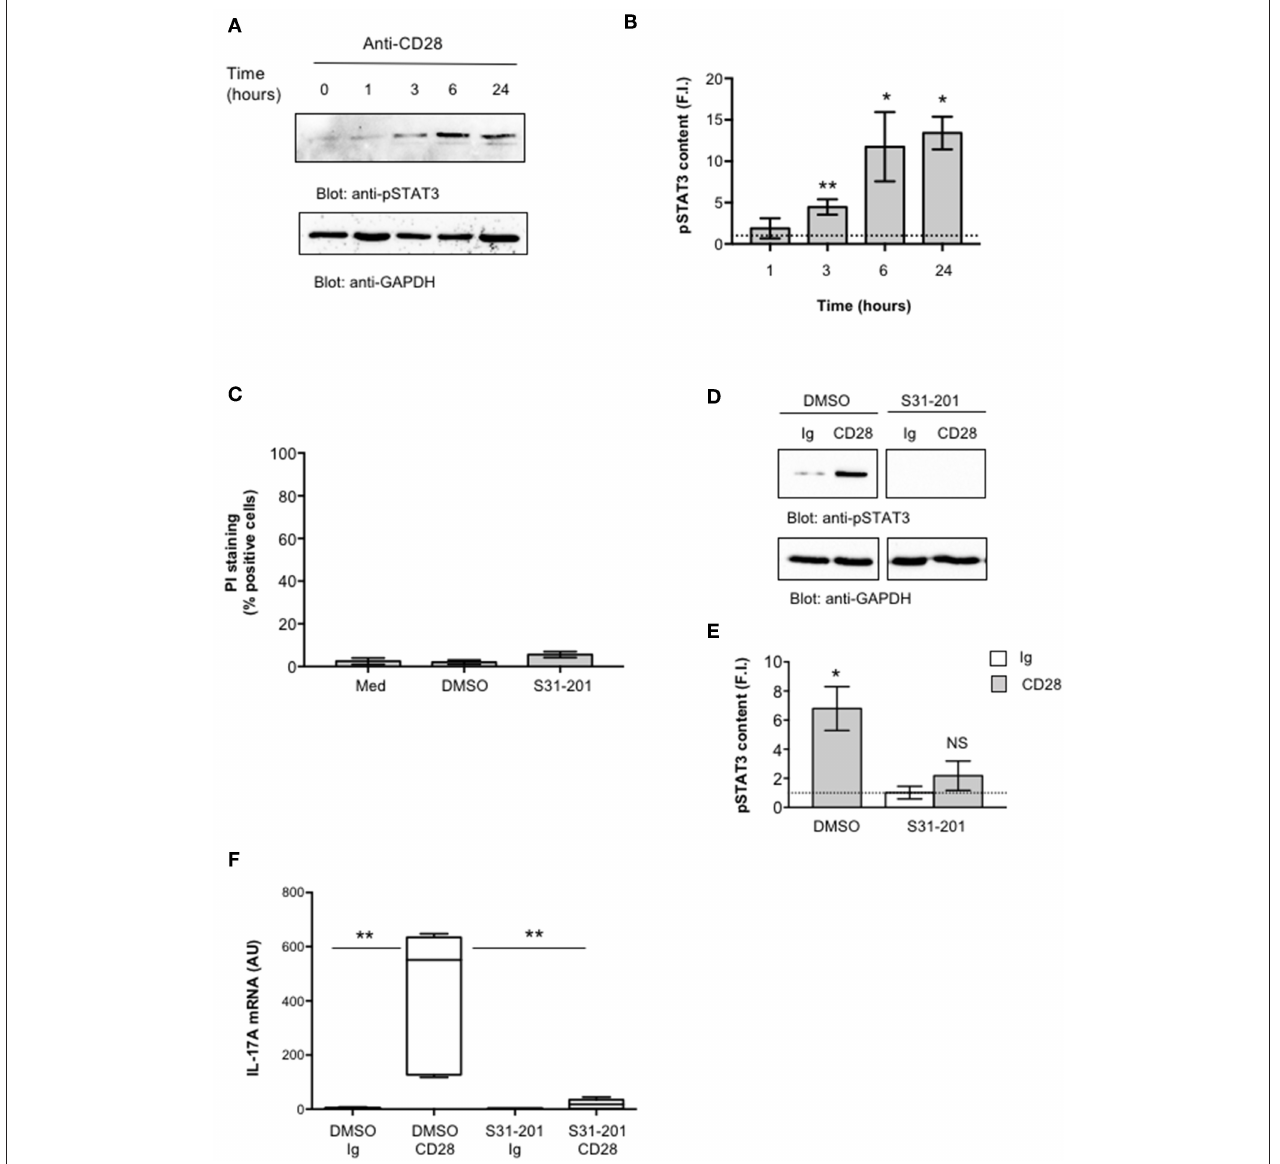
FIGURE 3 | STAT3 regulates CD28-mediated up-regulation of IL-17A. (A) CD4 + T cells were stimulated for the indicated times with isotype control Ig or anti-CD28.2 Abs and STAT3 phosphorylation on tyrosine 705 (pSTAT3) and GAPDH levels were analyzed by western blotting. (B) pSTAT3 fold inductions (F.I.) were quantified by densitometric analysis and normalized to GAPDH levels. Bars represent mean F.I. ± SEM of three HD. * p < 0.05, ** p < 0.01 calculated by Student t -test. (C) CD4 + T cells from HD ( n = 4) were cultured for 24h with medium (Med) or DMSO, as vehicle control, or 100 µ M S31-201 STAT3 inhibitor. Cell death was analyzed by flow cytometry by quantifying the ability of cells to incorporate propidium iodide (PI). The percentage of PI positive cells was calculated. Results express the mean ± SEM. (D) Western blotting of pSTAT3 and GAPDH levels in CD4 + T cell treated with DMSO, as vehicle control, or S31-201 and stimulated for 6h with isotype control Ig or anti-CD28.2 Abs. (E) pSTAT3 fold inductions (F.I.) were quantified by densitometric analysis and normalized to GAPDH levels. Bars represent mean F.I. ± SEM of three HD. * p < 0.05, calculated by Student t -test. NS, not significant. (F) IL-17A mRNA levels in CD4 + T cells from HD ( n = 5) treated with DMSO or S31-201 and stimulated for 24h with isotype control Ig or anti-CD28 Abs. Lines represent median values (AU) and statistical significance was calculated by Mann-Whitney test. Median values: DMSO Ig = 1, DMSO CD28 = 551, S31-201 Ig = 1.94, S31-201 CD28 = 18. ** p < 0.01.